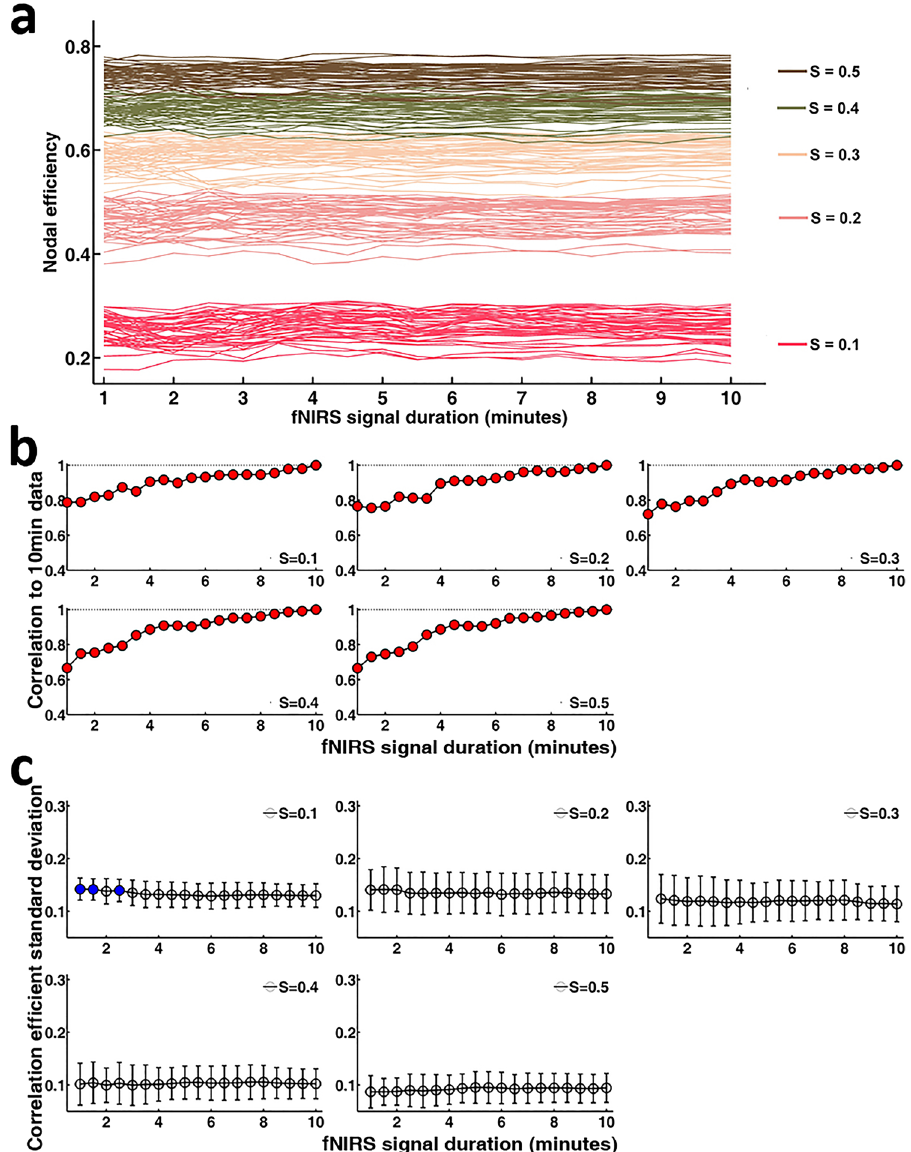
Figure 3. Effect of fNIRS signal acquisition duration on the accuracy and stability of nodal efficiency. ( a ) Magnitude of nodal efficiency at different sparsity values (0.1, 0.2, 0.3, 0.4 and 0.5) plotted according to the duration of the fNIRS signal acquisition ranging from 1.0 to 10.0 min. Curves with the same color represent measurement channels from 1 to 46. Different colors represent nodal efficiency calculated at different sparsity threshold values. ( b ) The plots of the correlation strength calculated for the spatial pattern of nodal efficiency between short and long (10.0 min) signal durations. The red-filled circles indicate a significant correlation of the nodal efficiency map associated with a given fNIRS signal acquisition duration with the nodal efficiency computed using 10.0 min of fNIRS data. The analysis revealed significant ( P < 0.001) and strong correlations for all threshold conditions, indicating almost immediate accuracy of the nodal efficiency. ( c ) The plots of the nodal efficiency-associated standard deviation (mean ± SD) plotted according to the duration of the fNIRS signal acquisition (1.0–10.0 min in 30-sec bins). The blue-filled circles indicate a significant difference in the magnitude of the computed value associated with a given fNIRS signal acquisition duration compared with the magnitude when computed using 10.0 min of fNIRS data. These data approximately correspond to horizontal lines, with little difference between the magnitudes of the computed graph metrics for each fNIRS collection